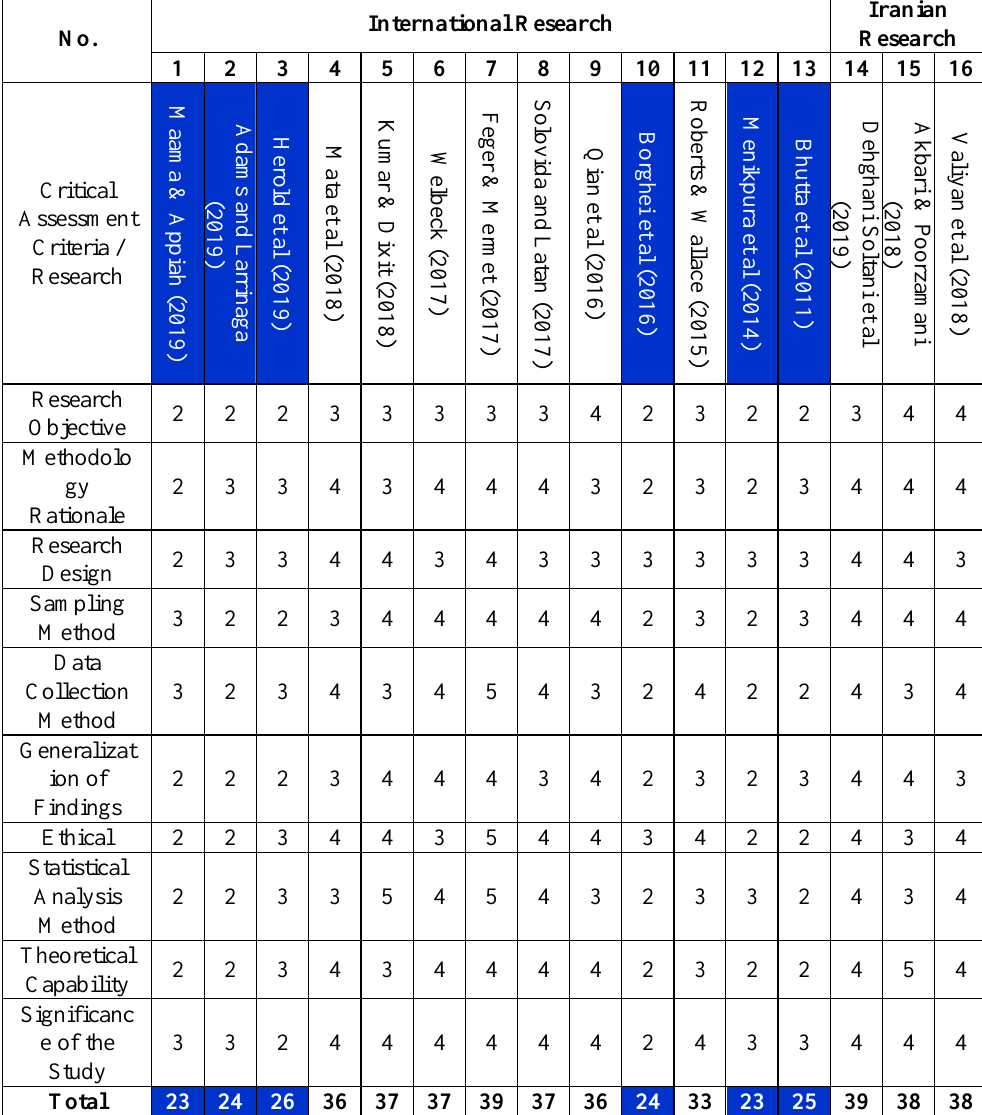
Table 2. Evaluation process of verified studies to determine the components and propositional